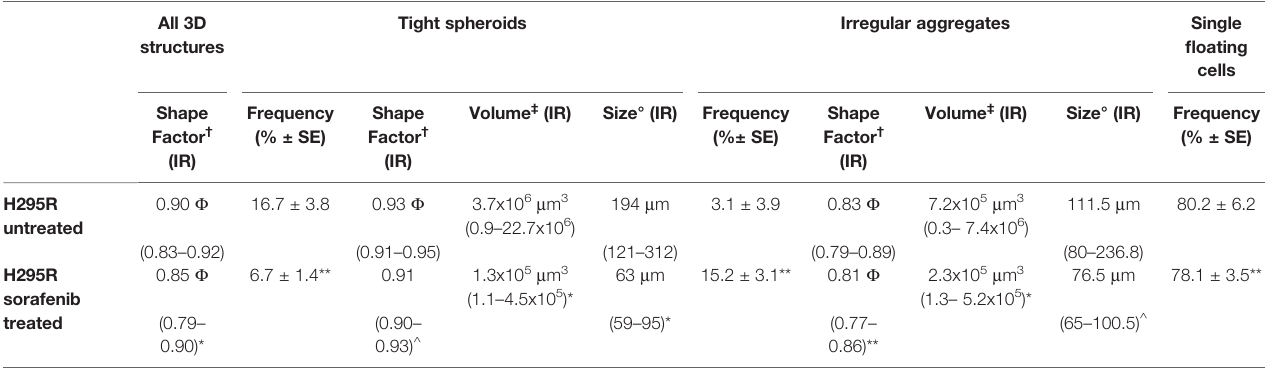
TABLE 1 | Morphological characterization and morphometric analysis of three-dimensional multicellular structures obtained from H295R cells cultured in sphere medium with or without sorafenib. All 3D Tight spheroids Irregular aggregates Single structures